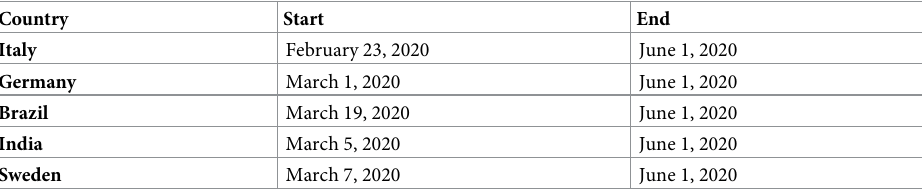
Table 1. Range of data for five countries: Italy, Germany, Brazil, India and Sweden. Country Start